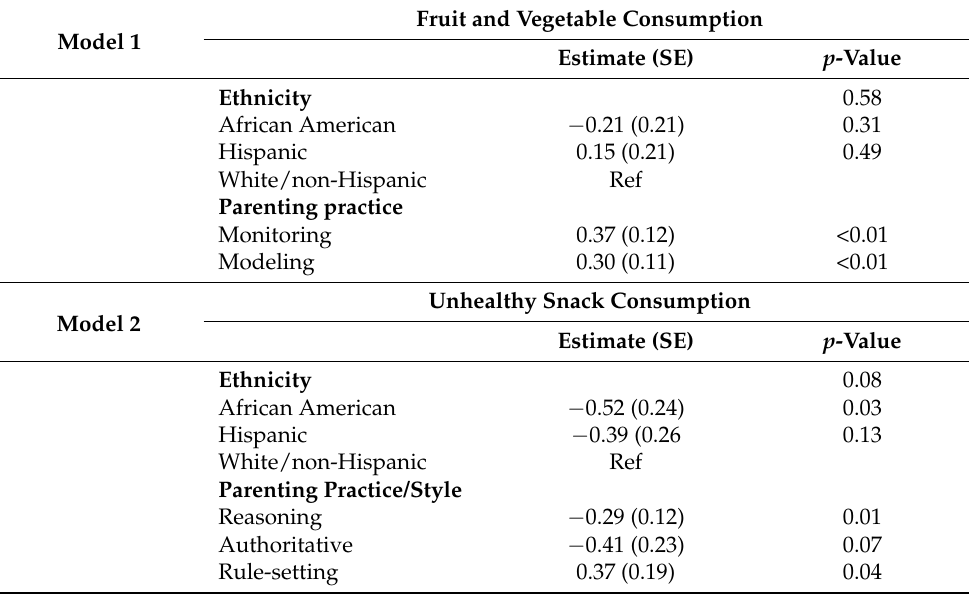
Table 8. Multivariate regression models for fruits and vegetables and unhealthy snack consumption.